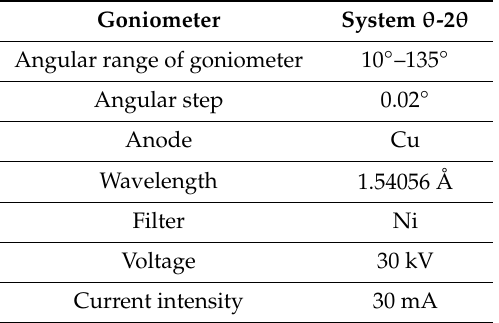
Table 10. Operational parameters of SIEMENS D5000 and X’Pert Philips (PW3050) di ff ractometers.